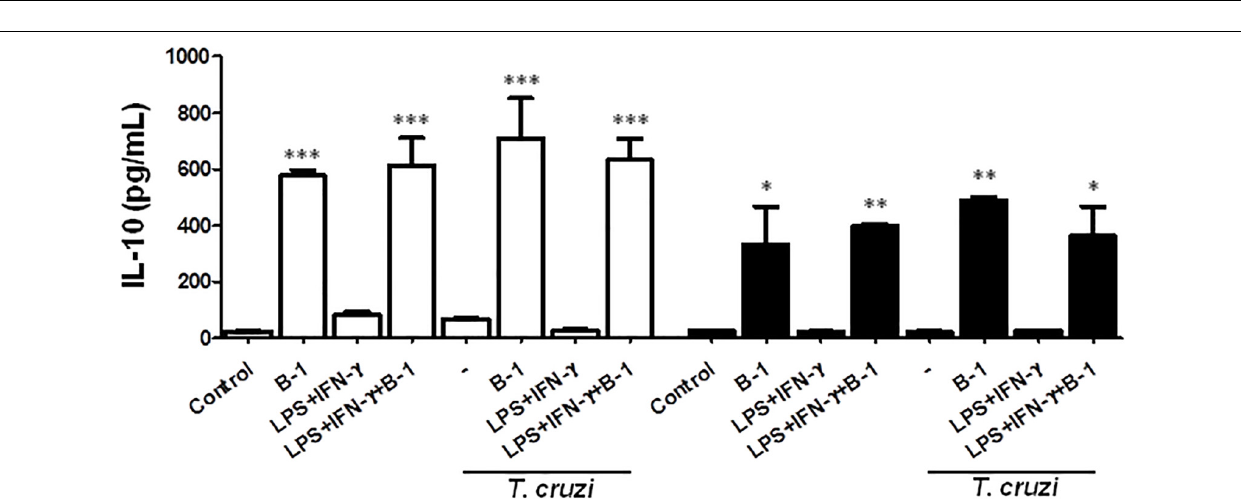
FIGURE 3 | The production of the IL-10 in macrophage: B-1 cell co-cultures. Peritoneal macrophages from BALB/c (white bars) or from XID mice (black bars) were plated (2x10 5 /mL) and infected with trypomastigotes forms of T. cruzi Dm28c clone at a 5:1 parasite-to-cell ratios in 1 mL of DMEM 10% FCS and incubated at 37 ◦ C in 5% CO 2 . After overnight incubation, the cell culture was washed and some cultures were co-cultivated with B-1 cells at a 10:1 B-1-to-macrophages ratios and stimulate the cultures with LPS (400 ng/mL) and IFN- γ (1.5 ng/mL). After 24 h, the supernatant was collected and IL-10 was measured by ELISA. The test detection limits for IL-10 were 15.6–1000 pg/mL. All cultures were performed in triplicate and bars show the mean + SD. Statistical analysis was performed by t -test from representative results of three similar experiment ( ∗ p < 0.05, ∗∗ p < 0.01, and ∗∗∗ p <